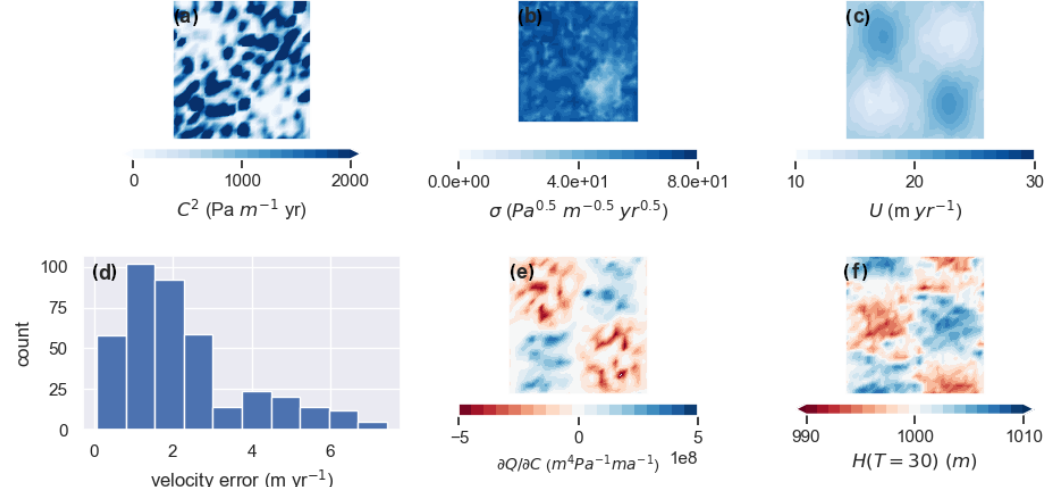
Figure 3. Similar to Fig. 2 but with γ = 1. Note the difference in color map with Fig.